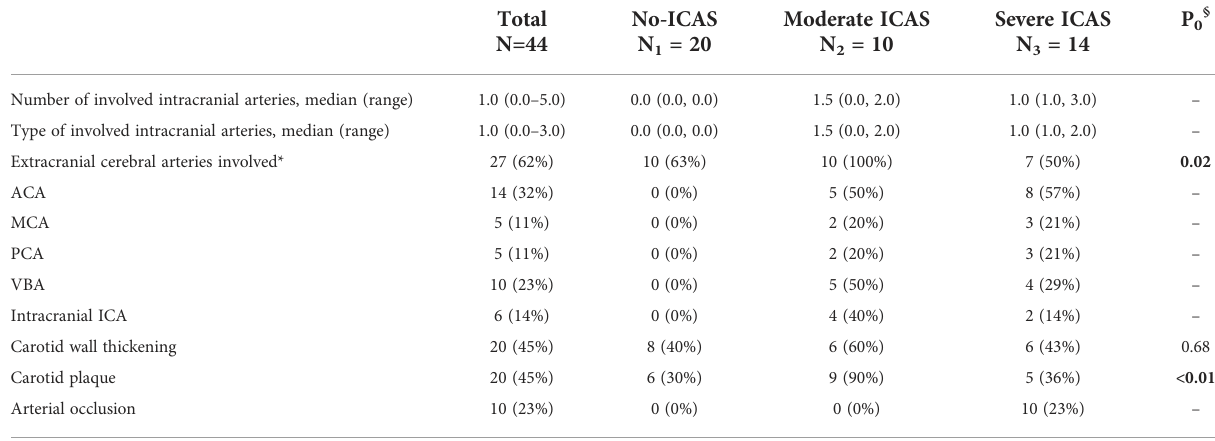
TABLE 3 The fi ndings of cerebral arterial Doppler ultrasonography scanning in 44 lupus patients with ischemic cerebrovascular disease.